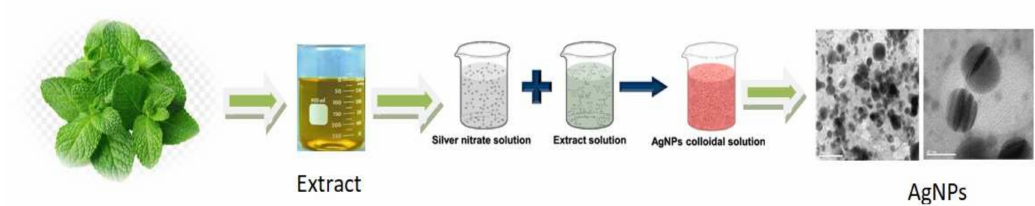
Figure 3. Synthesis of silver nanoparticles (AgNPs) using plant